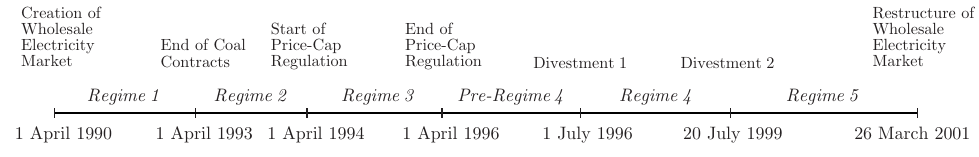
Figure 4. Regulatory reforms in the electricity supply industry in Great Britain during 1990–2001.